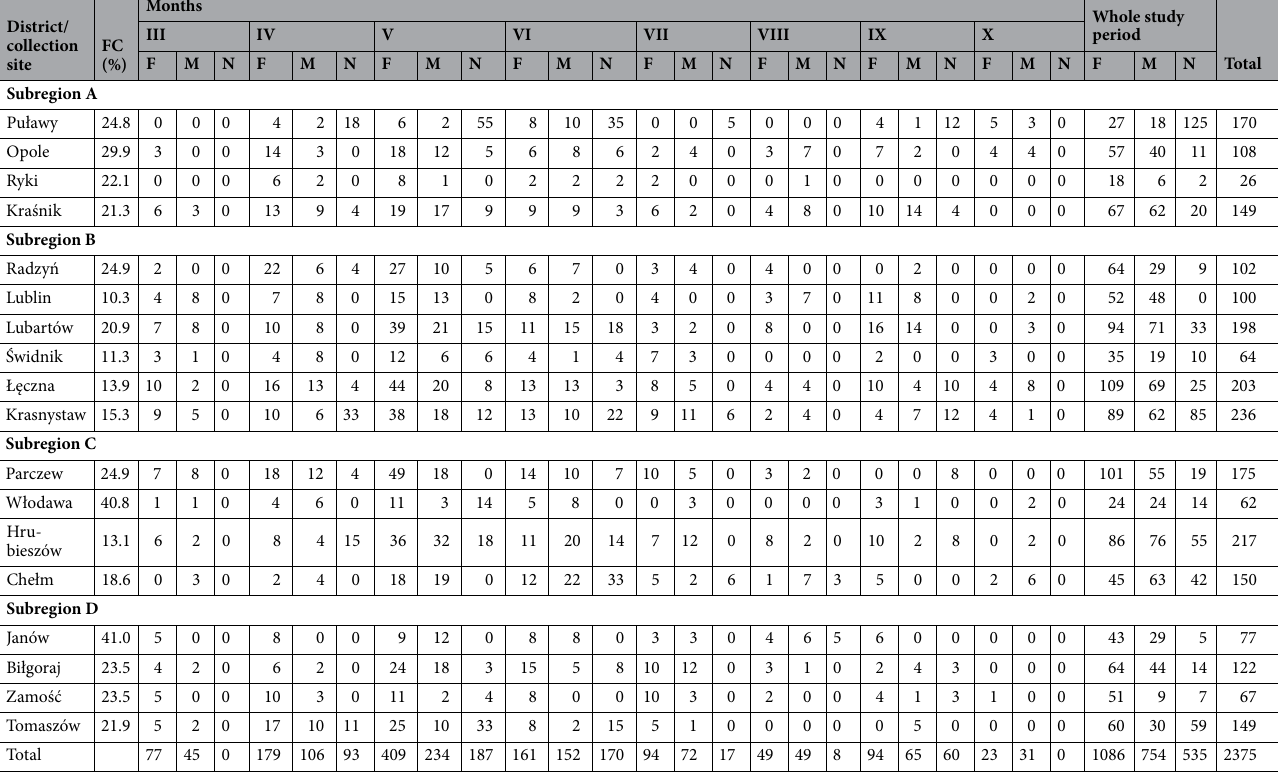
Table 1. Occurrence and number of Ixodes ricinus ticks in the study area in 2020 and the proportion of the forest cover in the overall land structure in the analyzed districts ( FC forest cover, F females, M males, N